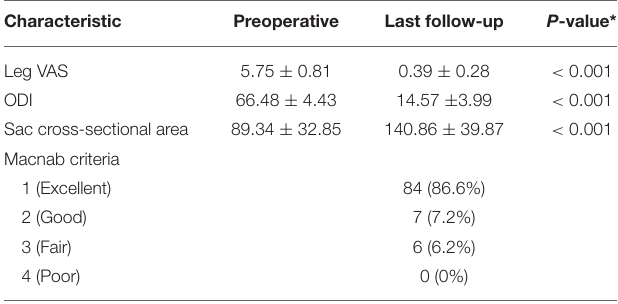
TABLE 2 | Preoperative and postoperative characteristics of the whole